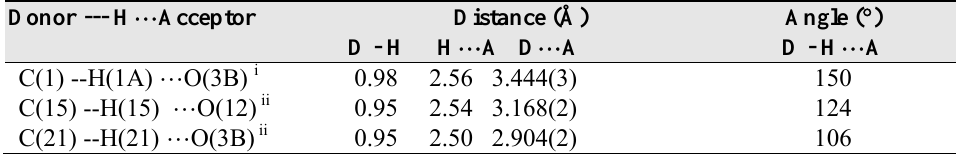
Table 2. Hydrogen bond data for I .